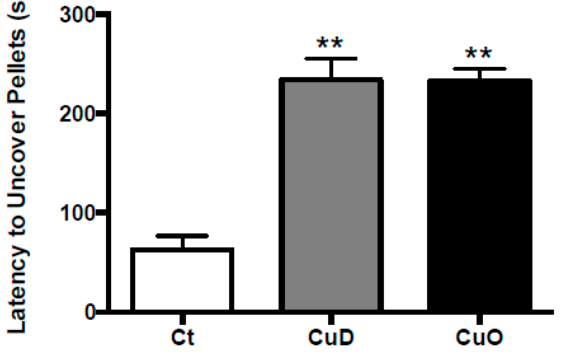
Figure 2. Buried pellet test to determine olfactory function. Rats were treated with CuD or CuO as described in Figure 1A. Tests were performed at the end of CuD or CuO treatment following three-day training and diet restriction. Data represents mean ± SEM, n = 14/group. **: p < 0.01, as compared to the control group, using Kruskal-Wallis nonparametric ANOVA analysis. Ct: control; CuD: Cu deficiency; CuO: Cu